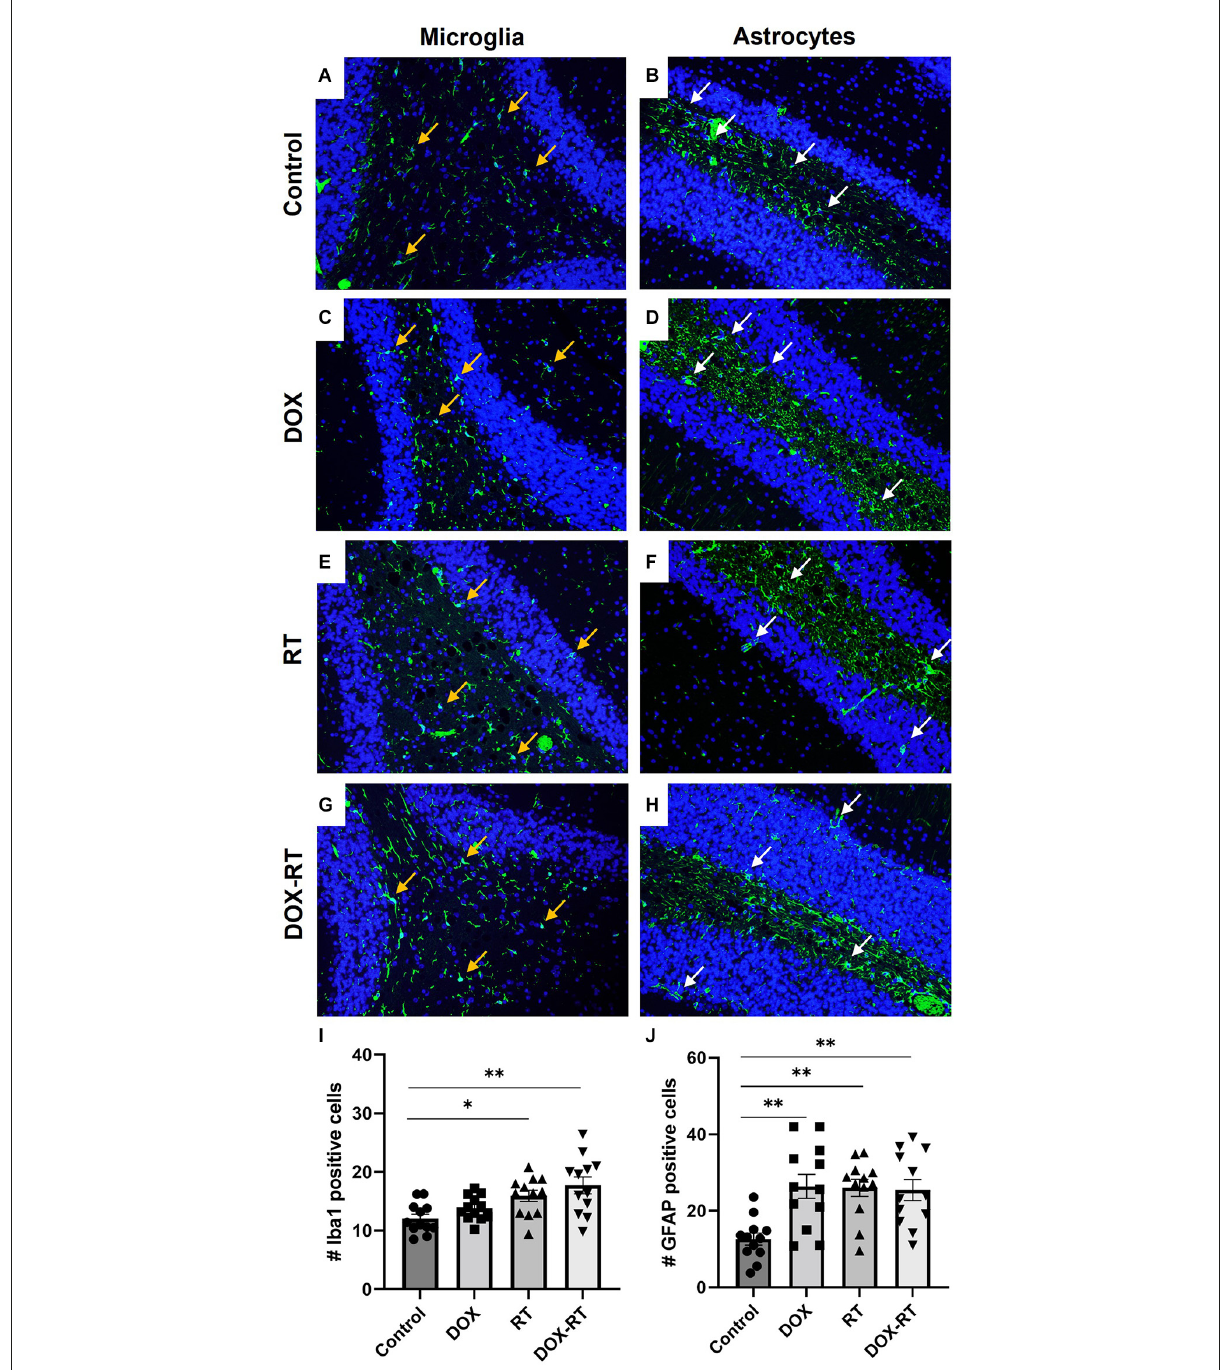
FIGURE4 Cancer therapy causes microgliosis and astrocytosis in the cerebellum. (A–H) Iba1+ microglia (A,C,E,G) are identified with orange arrows and GFAP+ astrocytes (B,D,F,H) are shown with white arrows. Representative images depict microglia and astrocytes from the cerebellum in control mice (A,B) and mice treated with DOX (C,D) , RT (E,F) or DOX-RT (G,H) . Images shown are at 200 × magnification. (I) Bar graph of Iba1+ microglia across treatment groups. Data represent the mean and SEM evaluated from four to five consecutive images per mouse ( n = 12 per group). Mice treated with RT or DOX-RT had significantly more Iba1+ microglia compared to control mice. (J) Bar graph of GFAP+ astrocytes across treatment groups. Data represent the mean and SEM evaluated from four to five consecutive images per mouse ( n = 12 per group). All treated mice had significantly more GFAP+ astrocytes compared to control mice. DOX, doxorubicin group; RT, hindlimb radiation group; DOX-RT, doxorubicin and hindlimb radiation group. One asterisk ( ∗ ) representing p -value < 0.05 and two asterisks ( ∗∗ ) representing p -value <